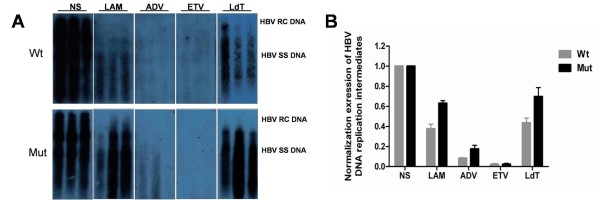
Drug susceptibility test of antiviral drugs on HBV replication using the HBV replication mouse model.A: HBV DNA replication intermediates were detected by southern blotting in the mouse model treated with NS (control), lamivudine (LAM), adefovir (ADV), entecavir (ETV) and telbivudine (LdT), respectively. B: The relative levels of HBV DNA replication intermediates in the mouse model among different groups. The levels of HBV DNA replication intermediates in NS treated wild-type group and mutant mice were set to 1 respectively, and the relative levels of treated groups were calculated accordingly.